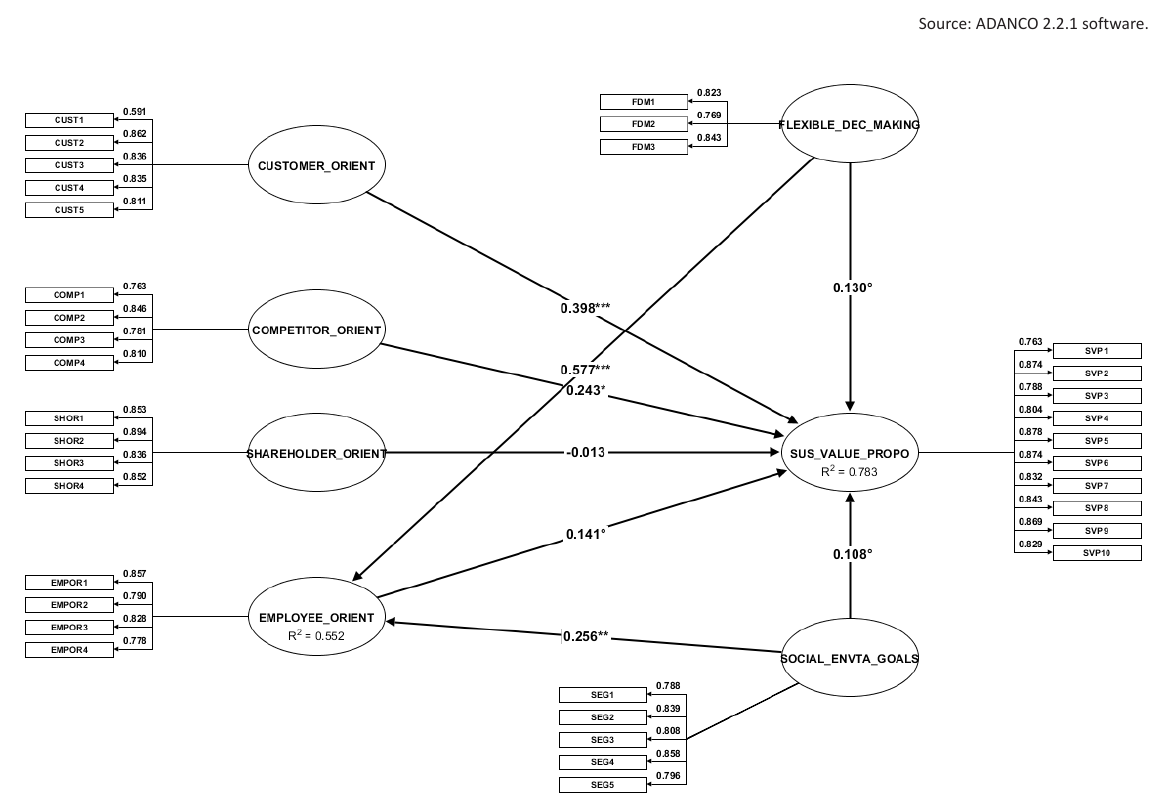
Figure A1. Estimated research model: Output